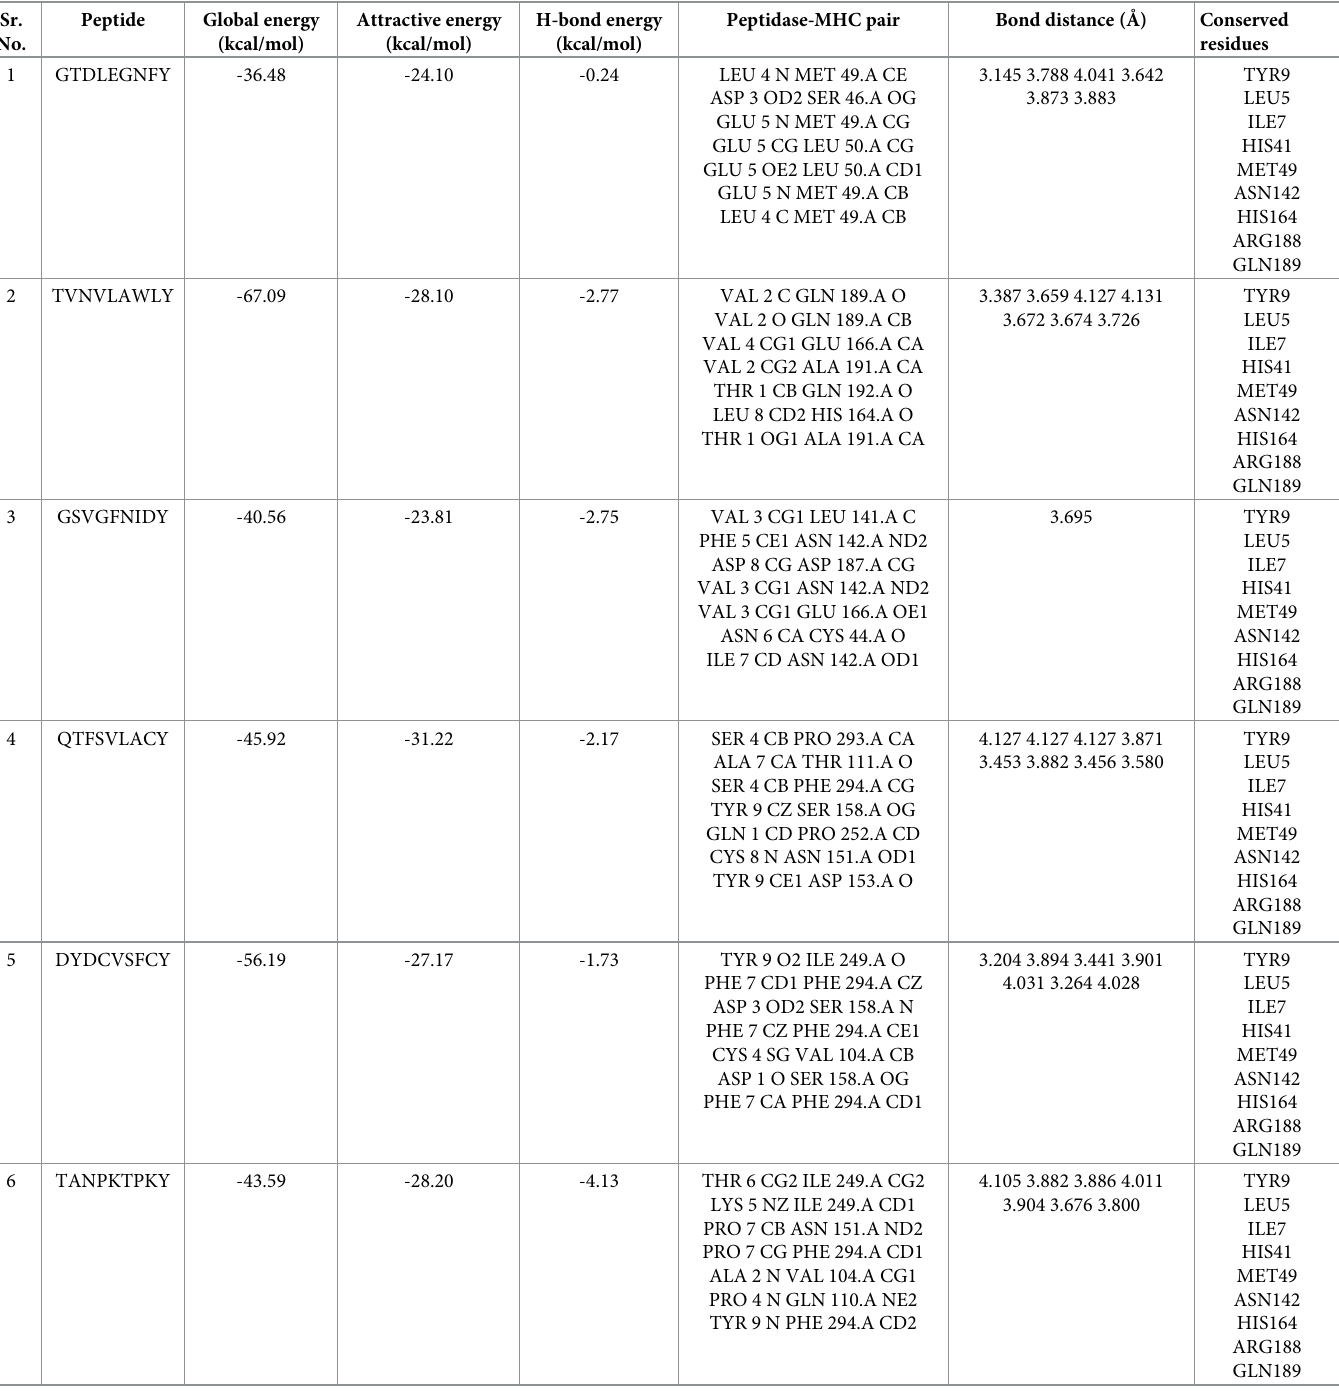
Table 3. Summary of designed peptides MHC class I HLA-B interactions against SARS-CoV-2. Sr.